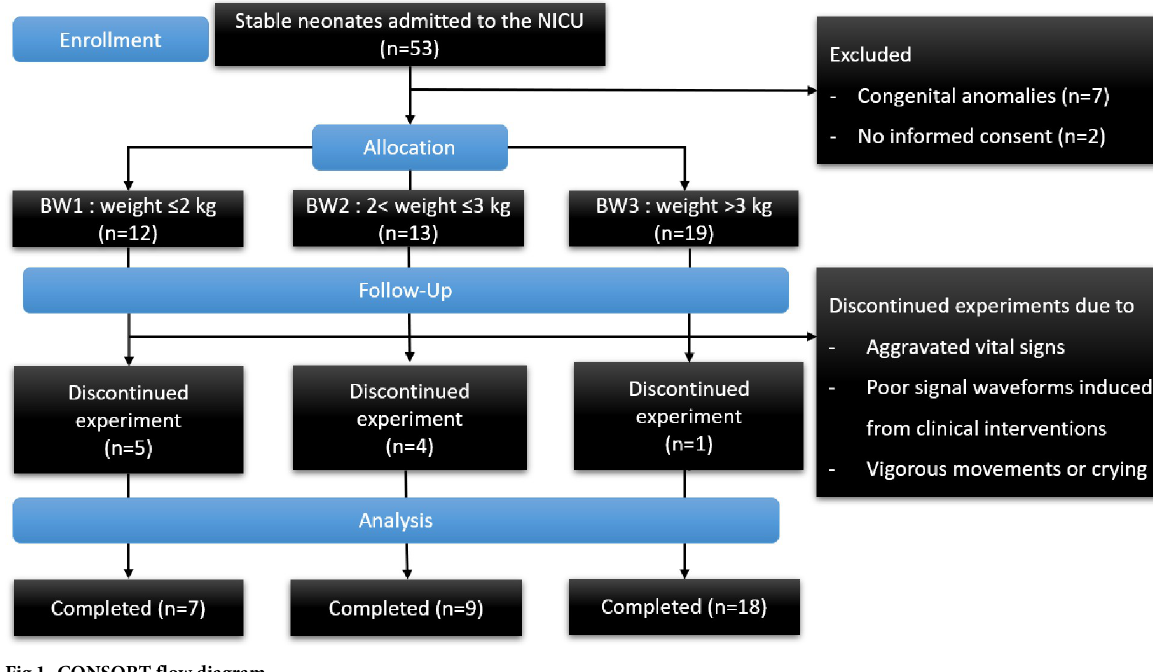
Fig 1. CONSORT flow